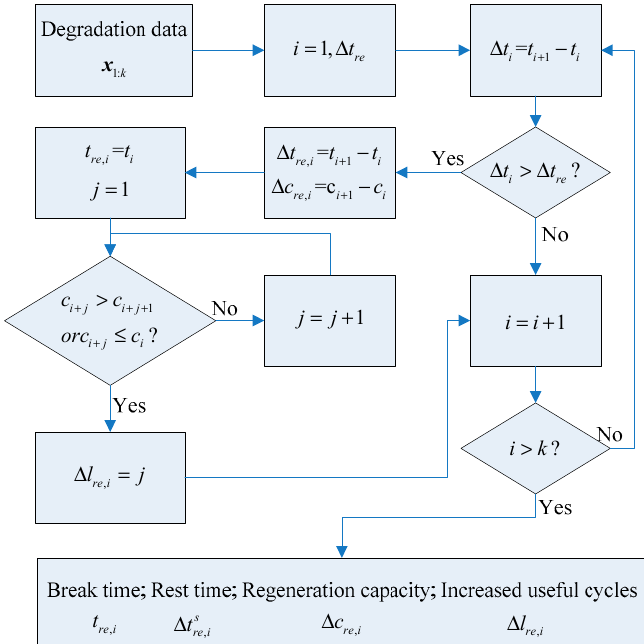
Figure 4. The algorithm flow chart for eliminating the recovery process.